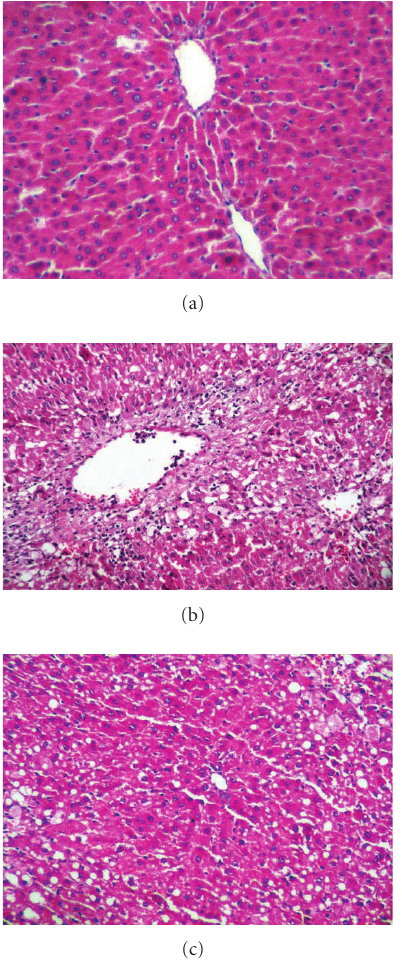
Figure 2: (a) Control (group 1): normal liver histology (H&E x200); (b) group 4: inflammation, necrosis was increased in group 4 (CCl 4 ) (H&E x200); (c) group 5: inflammation and necrosis was decreased in group 5 (CCl 4 +genistein): (H&E x200).